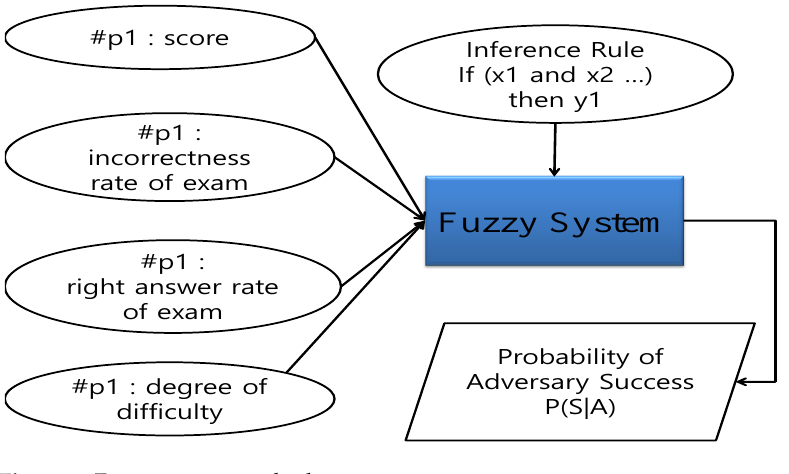
Figure 4. Fuzzy system method. Table 1. Input–output data for learning by level and inference